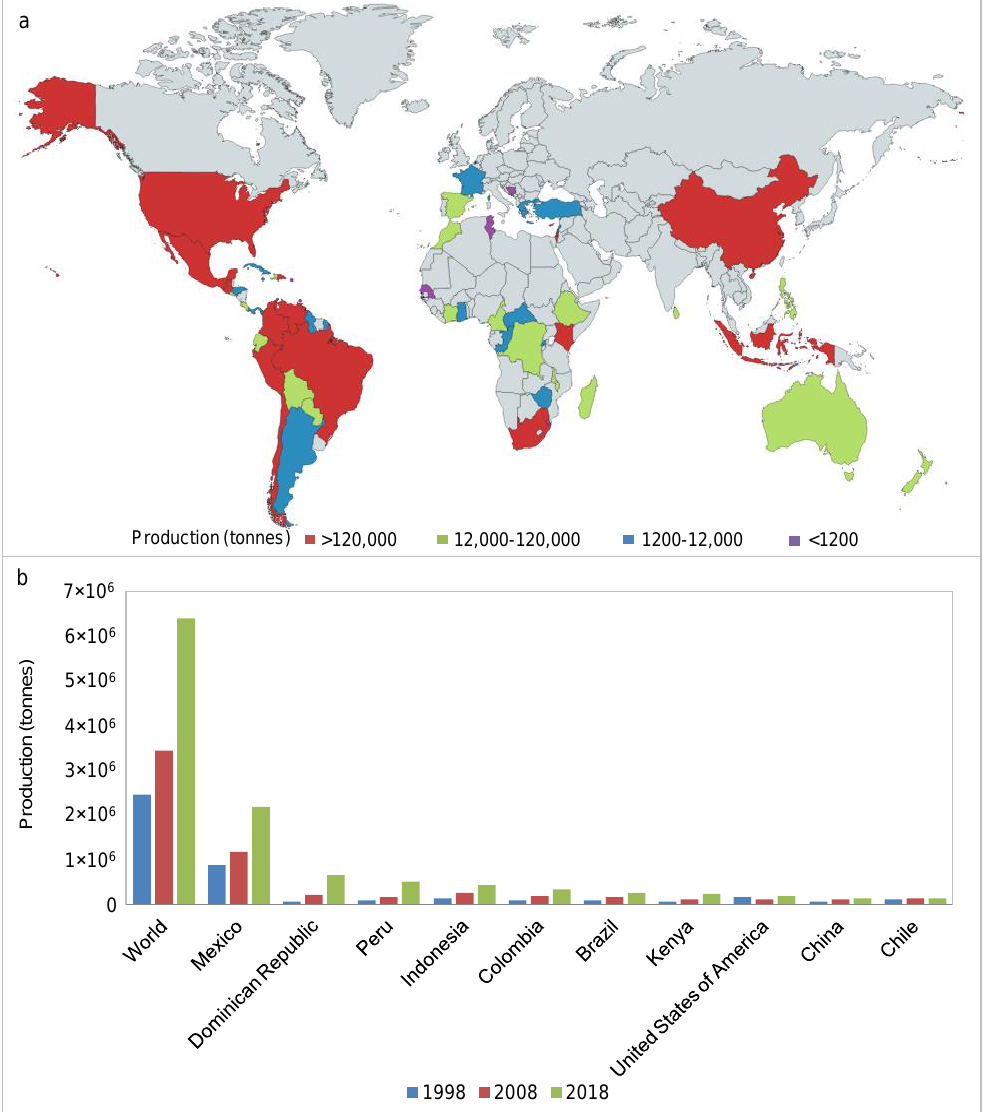
Figure 1. Production quantities of avocados by country in 2018 (created with mapchart.net) ( a ) and by the top 10 producers in 1998, 2008, and 2018 ( b ). Based on FAOSTAT data [6]. Avocado has a dark green, rough rind that covers a yellow-green pulp rich in oil [7]. Avocado has a unique texture, a smooth, buttery consistency, and an exquisite taste and aroma compared to most fruits, which present a typically sweet or acidic taste [8]. In addition to its pleasant organoleptic characteristics, avocado consumption has caught consumers’ attention owing to its high nutritional value and reported health-benefits, the main driver for buying avocados [9]. An avocado fruit